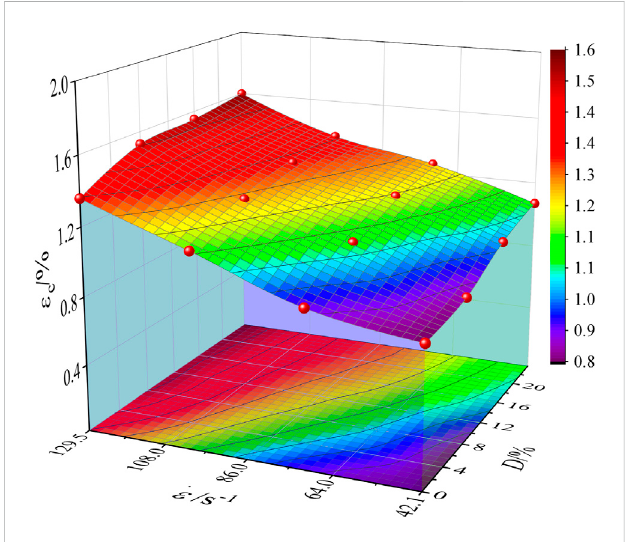
FIGURE 5 Coupling effect of initial damage and strain rate on dynamic peak strain.